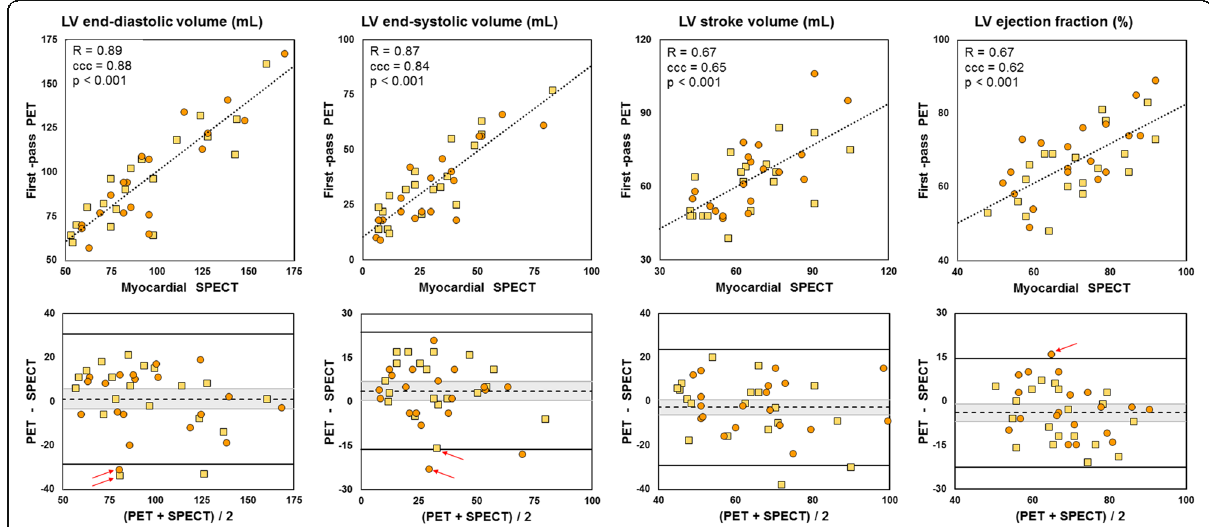
Fig. 3 Correlation and agreement between left ventricular volume and function obtained using myocardial SPECT and first-pass PET. Yellow square markers stand for rest studies and orange round markers for stress studies. Top: scatter plots. The dotted lines stand for the linear regression ( R , Pearson ’ s correlation; ccc, Lin ’ s concordance correlation coefficient). Bottom: Bland-Altman diagrams. The dashed lines indicate the mean difference (greyed is the 95% confidence interval) and the plain lines the 95% limits of agreement. The outliers labelled using red arrows refer to a single patient with an antero-septo-apical scar from prior